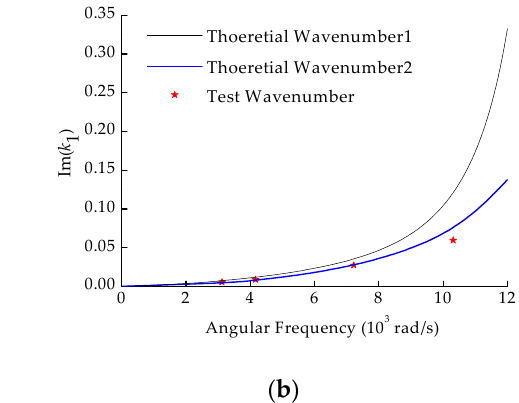
Figure 7. The comparison between the theoretical wavenumbers and the field test wavenumbers. ( a ) Real part; ( b ) Imaginary part.